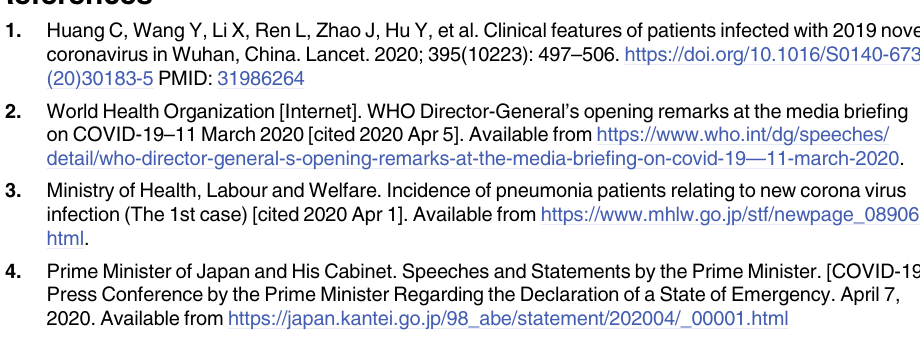
S1 Fig. Complete mobility network diagram in Japan in 2016. S1 Table. Total number of cases in each prefecture. S2 Table. Infection arrival time for each